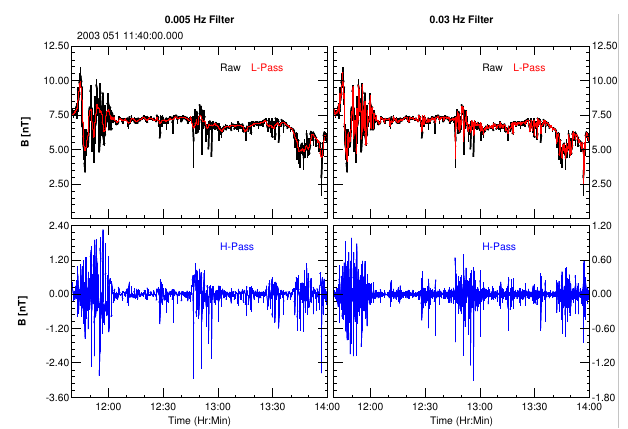
Fig. 2. Mean field removal for two Savitzky-Golay low pass filters (0.005Hz and 0.03 Hz). The top row of plots shows the input data (black) and the low-pass filter (red). The lower row of plots shows the high-pass data formed by subtracting the low-passed data from the input data. The high-passed data constitute the variable compo- nent of the field used in the estimation of λ T